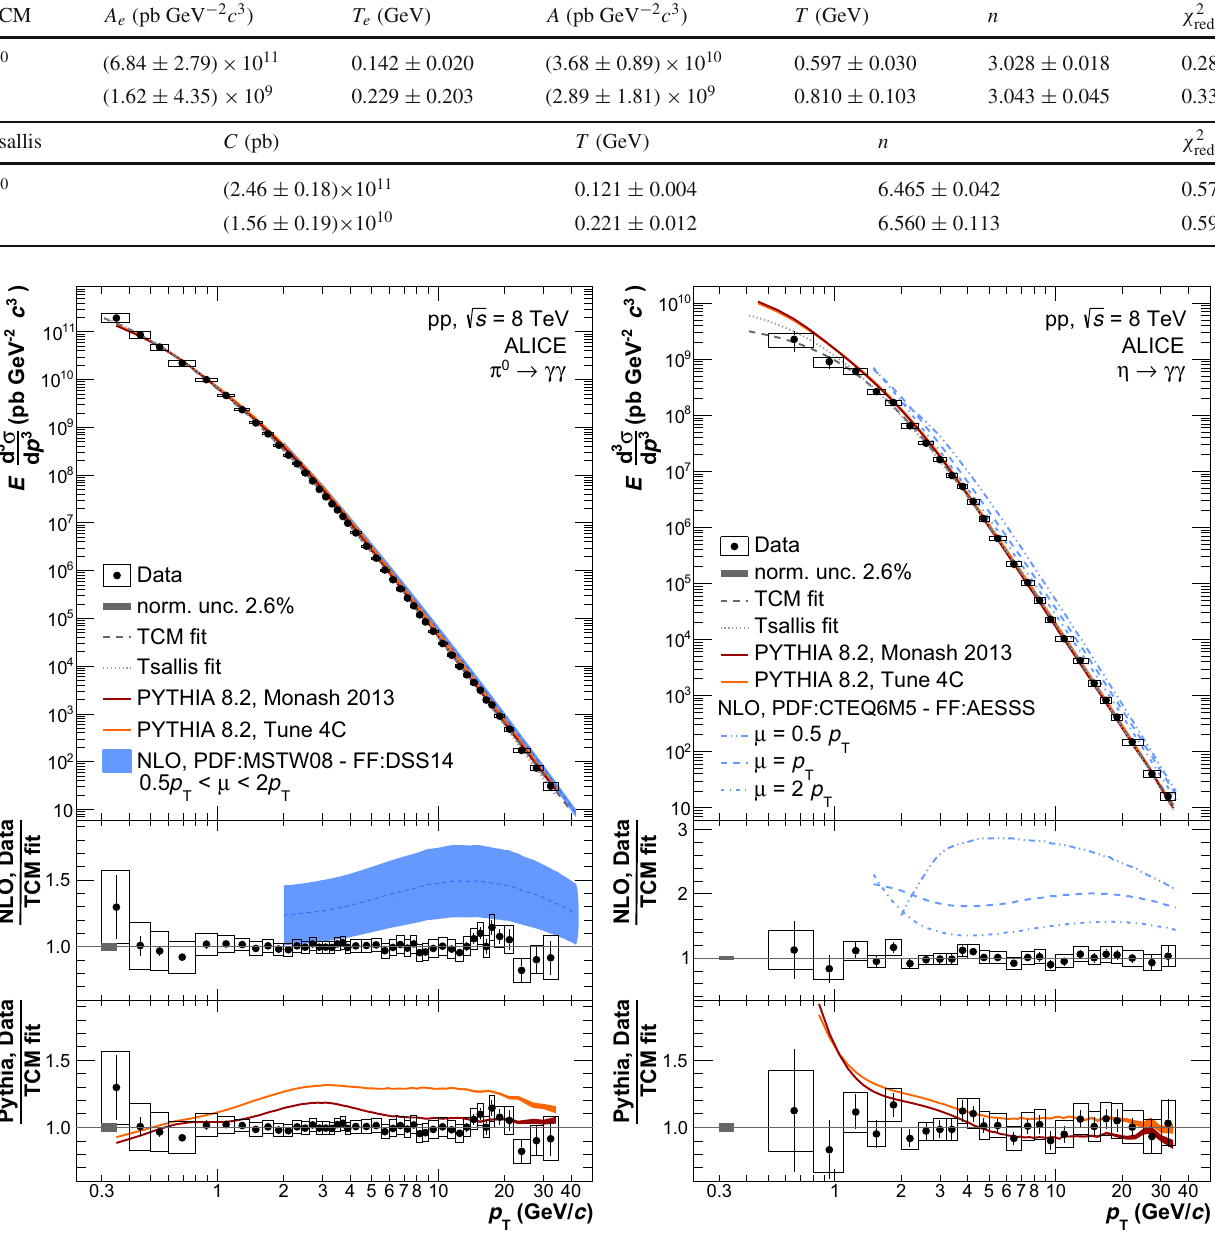
Fig. 7 Invariant cross sections for neutral meson production are shown together with NLO pQCD predictions using PDFs MSTW08 (CTEQ6M5) with FFs DSS14 (AESSS) for π 0 ( η ) as well as